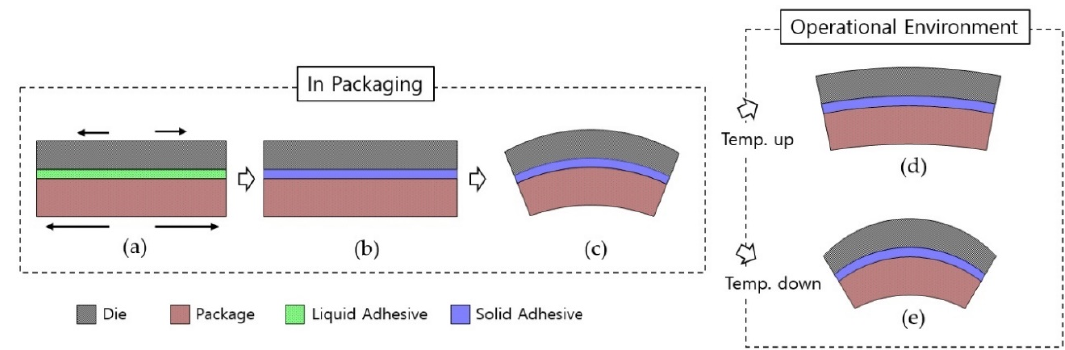
Figure 1. Change in Die Warpage: ( a ) T < adhesive curing temp.; ( b ) T = adhesive curing temp.; ( c ) cooling to room temp.; ( d ) room temp. < T < adhesive curing temp.; ( e ) T < room temp.